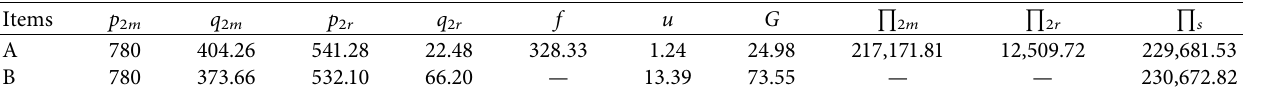
Table 3: The results in scenario 2 with cap-and-trade regulations.